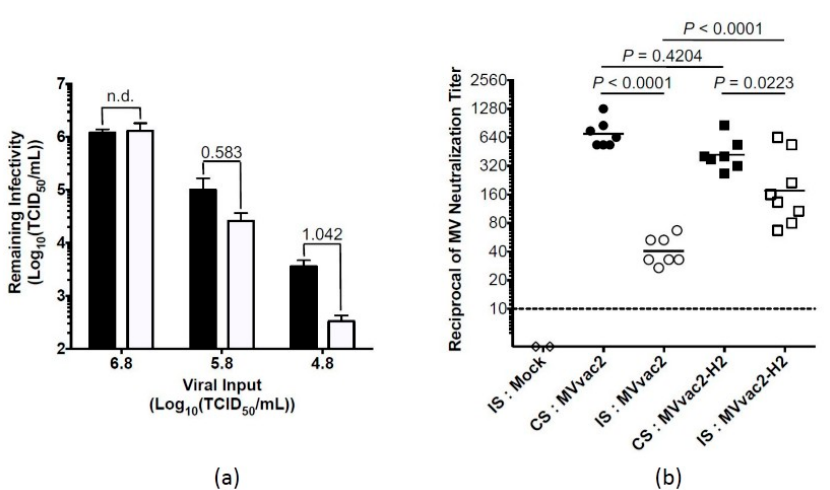
Figure 2. Immunogenicity of MV expressing additional H in the presence of artificially acquired anti-measles antibodies at levels capable of reducing viral titer ex vivo: ( a ) artificially introduced MV-immune serum reduces MVvac2 infectivity ex vivo. Five-week-old MV-susceptible mice were inoculated with equivalent amounts of diluted irrelevant control (black bars) or MV-hyperimmune serum (white bars). Pooled sera obtained from these animals the day after passive transfer was assayed for its impact on MV infectivity after incubation with varying titers of MVvac2. Remaining viral titers following incubation are reported, with bars indicating the standard deviation of three experiments. The logarithmic difference in MV infectivity is numerically annotated above each bar pair, with n.d. indicating no difference; ( b ) anti-MV neutralizing immunity in the presence of artificially introduced neutralizing antibodies. One day after the artificial passive transfer of control serum (CS, black symbols) or immune serum (IS, white symbols), mice from ( a ) were vaccinated with 10 5 TCID 50 MVvac2 (circles) or MVvac2-H2 (squares), or mock vaccine (diamonds). Mice were bled 28 days post-vaccination, and anti-MV neutralizing titer was determined. Each symbol represents one animal. Solid horizontal lines represent group geometric mean. The interrupted horizontal line indicates the limit of detection. Statistical significance of differences in neutralizing immunity was assessed by two-way ANOVA on log 2 -transformed reciprocal titers, followed by Sidak’s multiple comparisons test.